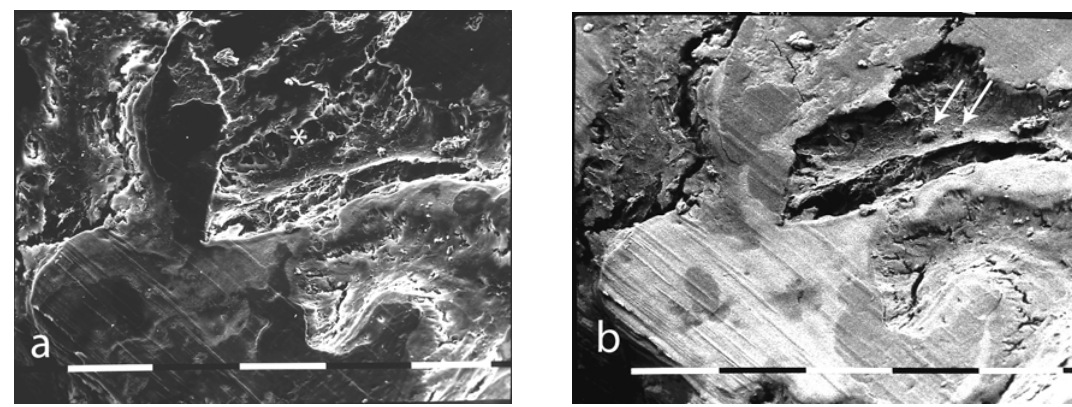
FIGURE 10. SE (a) and BSE (b) images of peri-implant tissue around SS implant 3 months after surgery. Newly formed compact bone can be seen in direct contact with the removed implant surface. Straight calcified ridges (down on the left) correspond to the implant machining treatment. Different density areas of mature bone correspond to different calcification ages. Marrow spaces (*) with cells (arrows) and blood vessels are detectable. Bar = 10 µm.